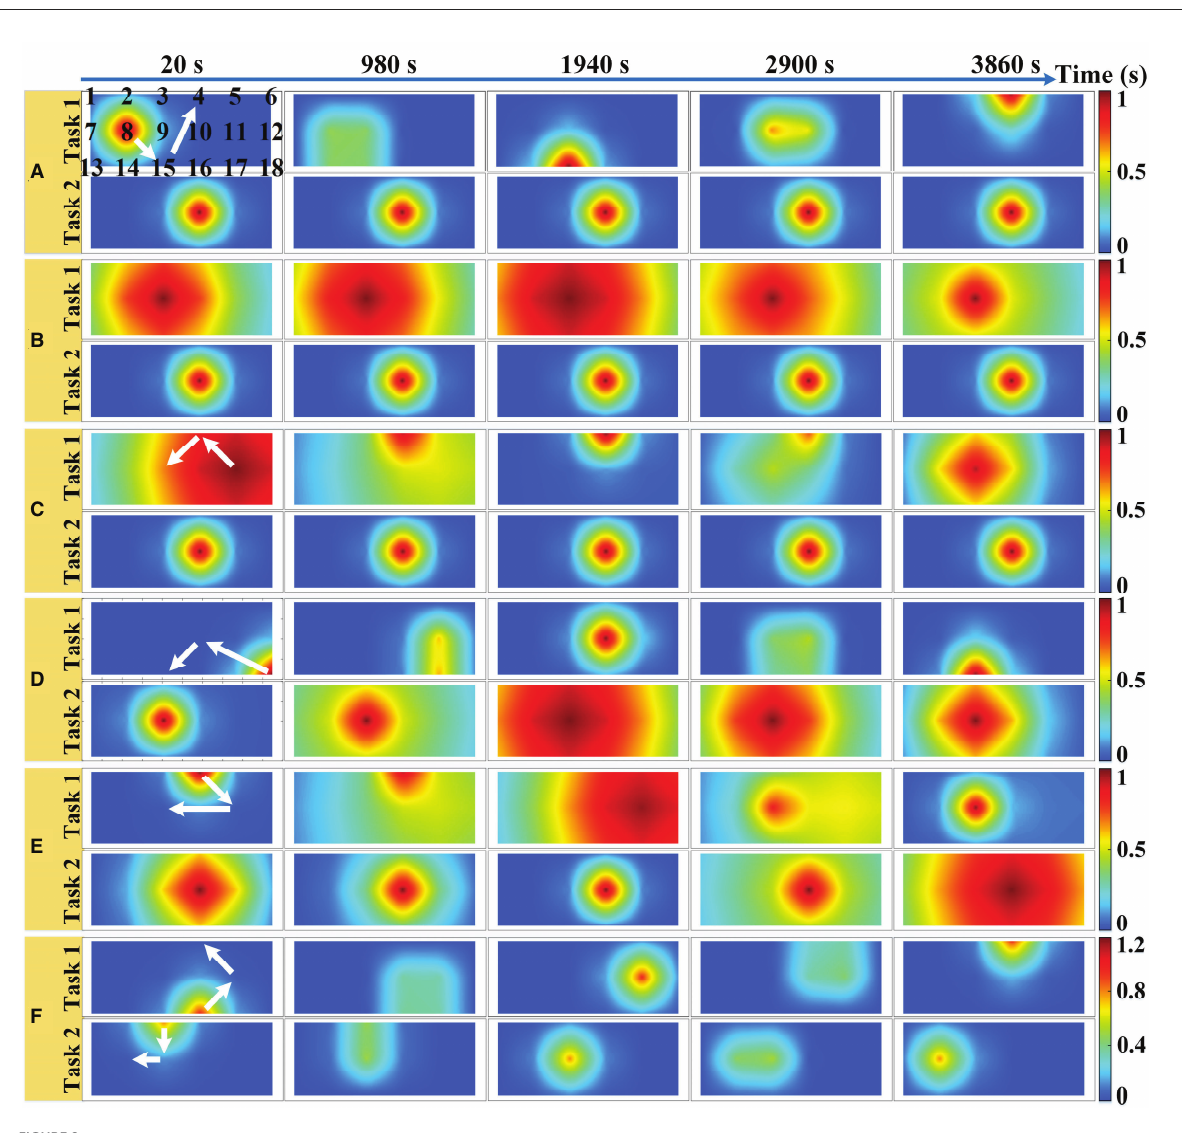
We use a total of four source-pairs, each containing both 785nm and 830 nm laser diode sources and four photomultiplier (PMT) detectors form a single-lattice arrangement